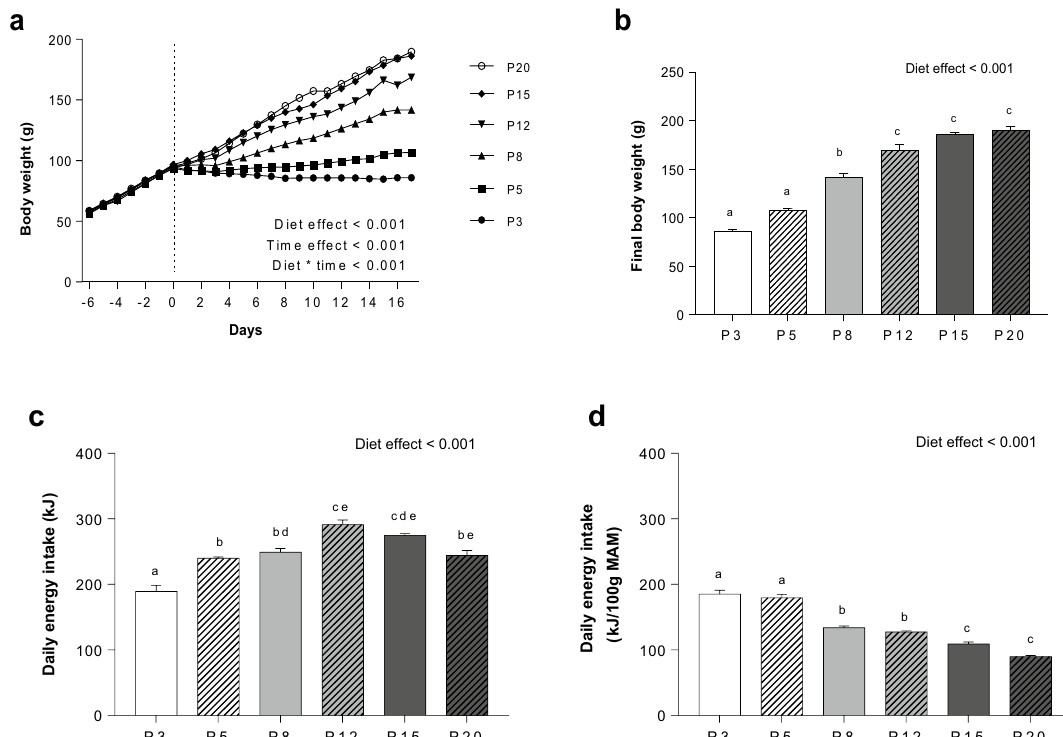
Figure 1. Effect of protein deficiency on body weight and energy intake. ( a ) Evolution of body weight; ( b ) Final body weight; ( c ) Daily energy intake; ( d ) Energy intake adjusted to 100 g MAM. Values are means ± SEM (n = 6 per group). a,b,c,d,e Data that do not share the same letter are different at the P < 0.05